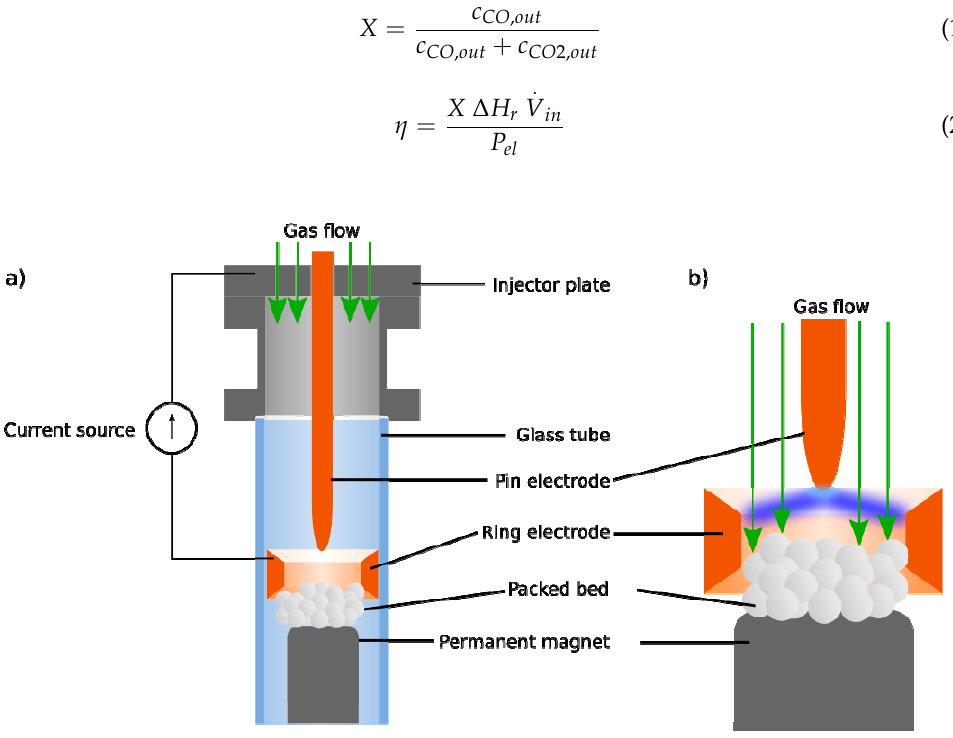
Figure 1. Overview over the plasma reactor assembly ( a ) and schematic view of the discharge ( b ).